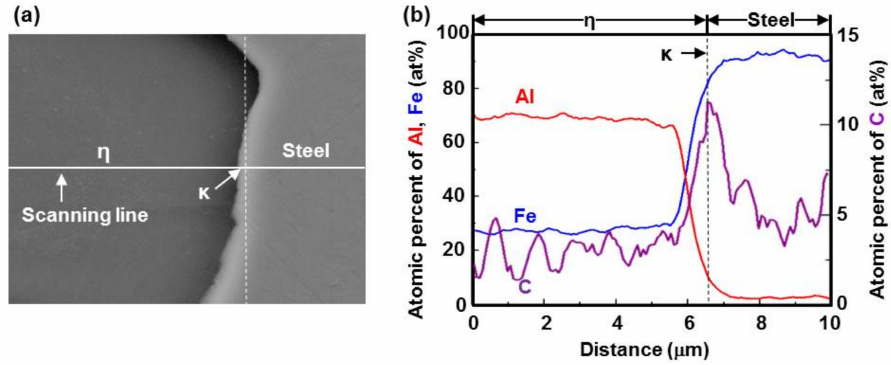
Figure 18. ( a ) The Fe2Al5 ( η ) phase/steel interphase SEM image and ( b ) concentration profiles of Fe, Al, and